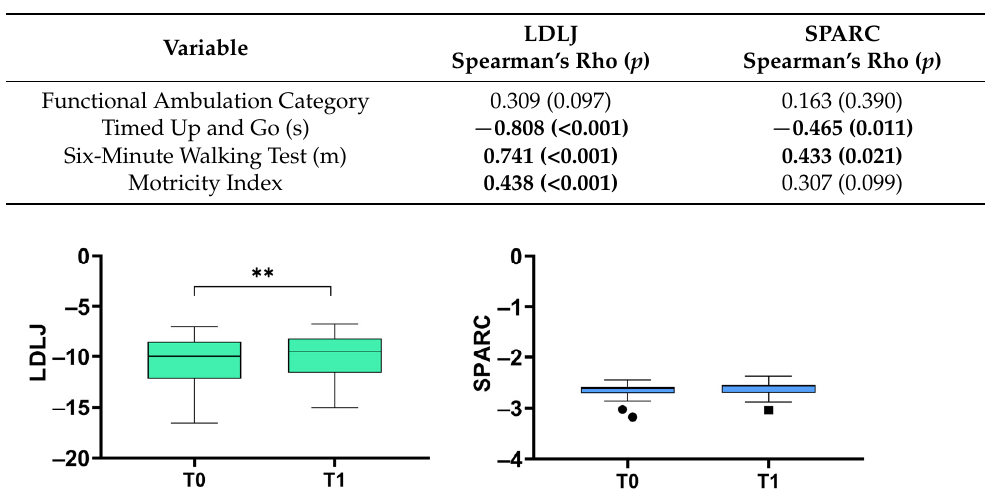
Figure 2. Discriminant validity analysis: ability of the two metrics (log dimensionless jerk, LDLJ, and spectral arc length, SPARC) in distinguishing the two gait cycles (affected or unaffected side), or subacute and chronic patients. The asterisks indicate a statistically significant difference (*: p < 0.05; *** p < 0.001). Table 3. Spearman’s rank correlation coefficient (Spearman’s rho) and p -values between the clinical scales and the two metrics of smoothness (log dimensionless jerk, LDLJ, and spectral arc length, SPARC). Values in bold indicate a statistically significant correlation ( p < 0.05).